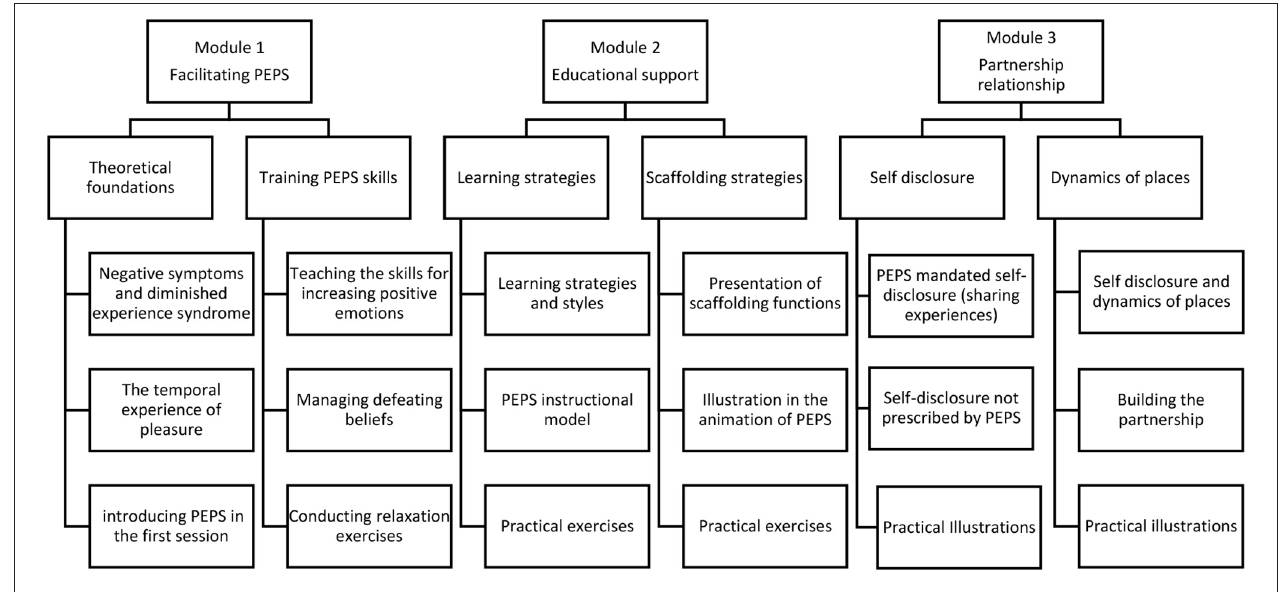
FIGURE 1 | Stage by stage content of the